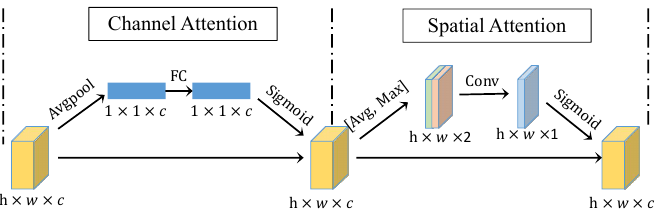
Figure 6. The structure of attention module [21], sequentially consisting of channel attention and spatial